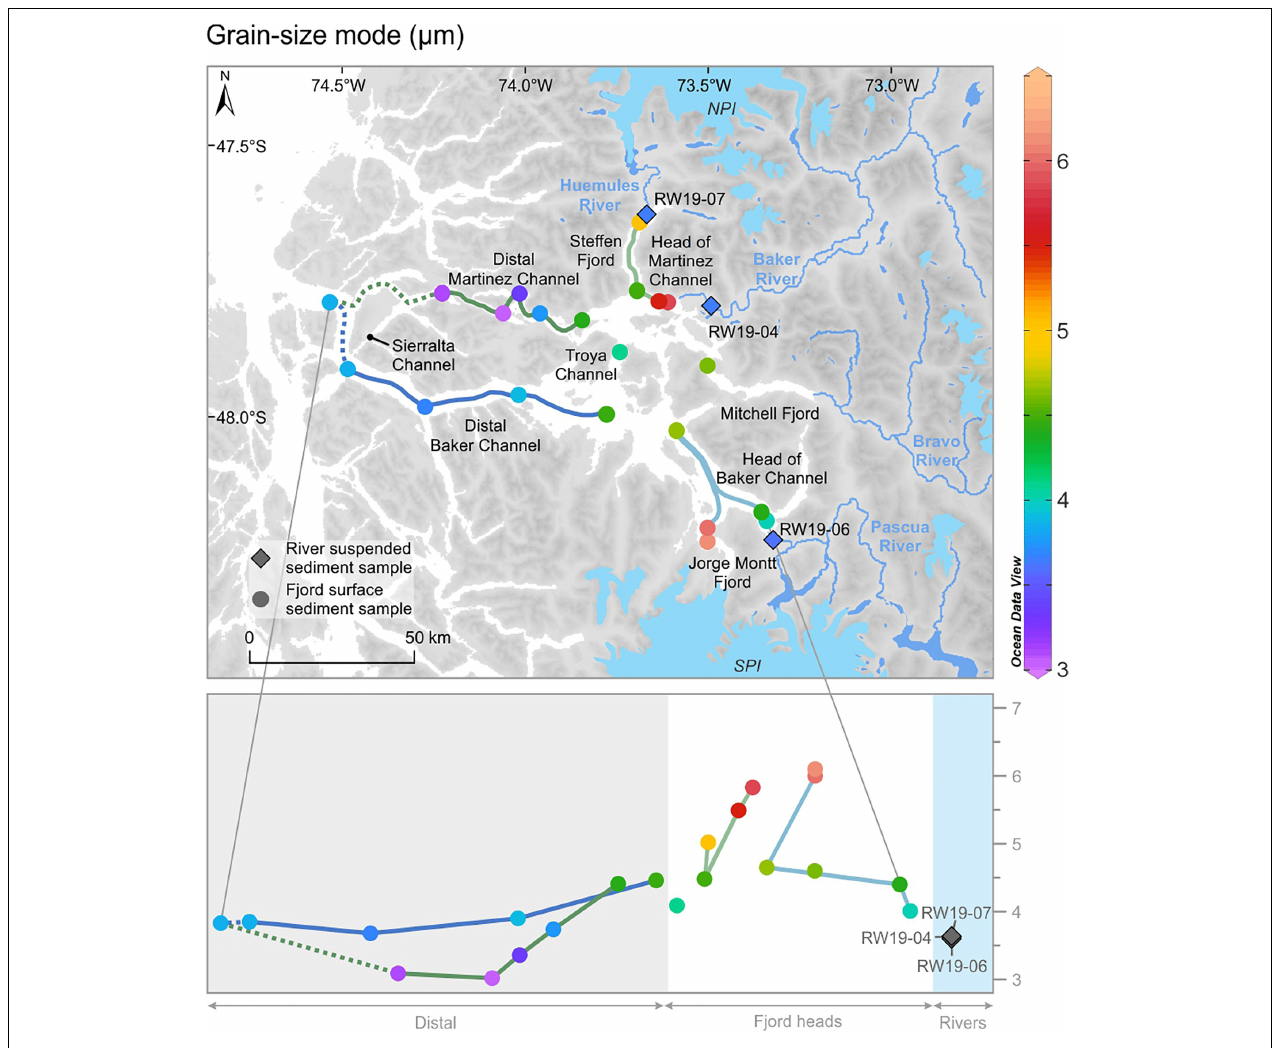
FIGURE 6 | Spatial variability in the grain-size mode of the fjord and river sediment samples. The colored lines between the fjord samples represent the four subsets with n > 1 ( Figure 2 ). In the bottom panel, the fjord samples are plotted according to